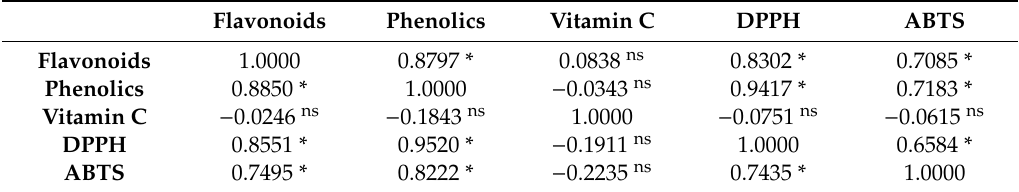
Table 3. Phenotypic (right side) and genotypic (left side) correlation matrix between bioactive compounds studied in 30 blue honeysuckle genotypes. Flavonoids Phenolics Vitamin C DPPH ABTS Flavonoids